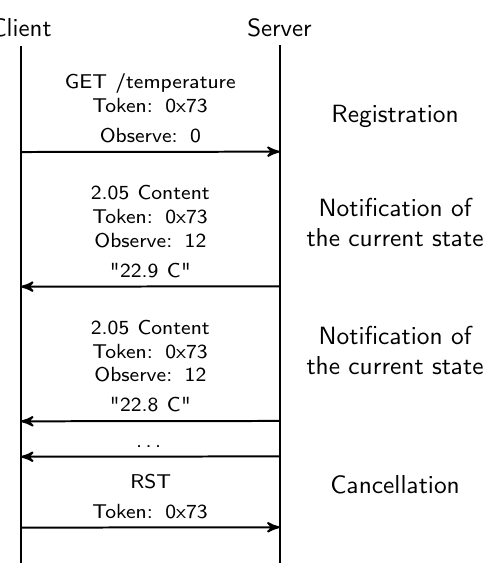
Figure 2. Observing a resource in